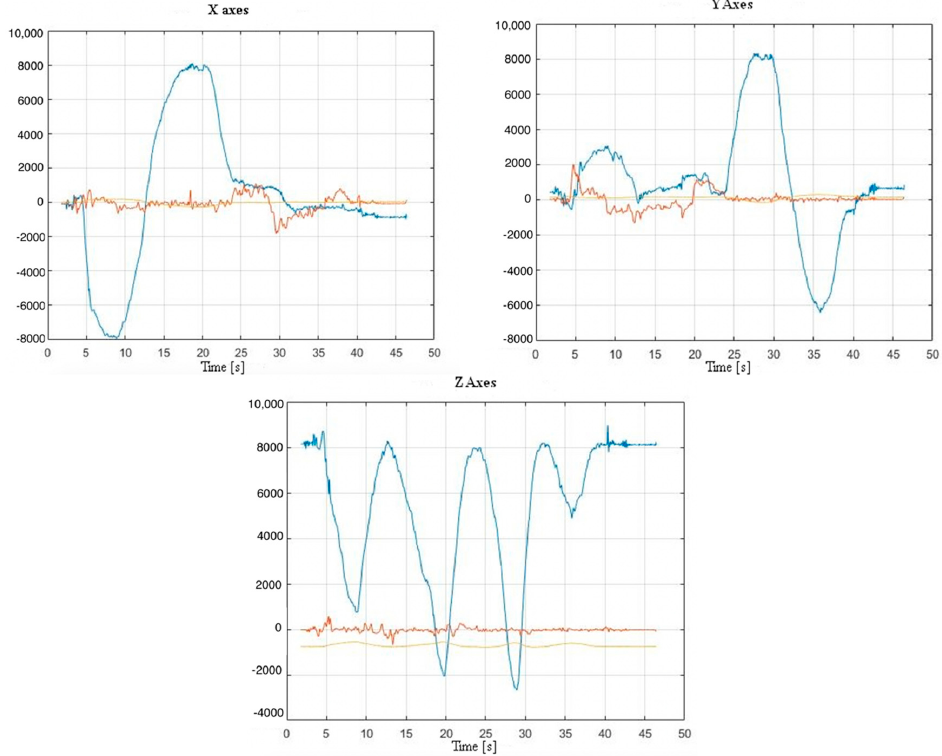
Figure 9. Raw measured output for the three degree of freedom.